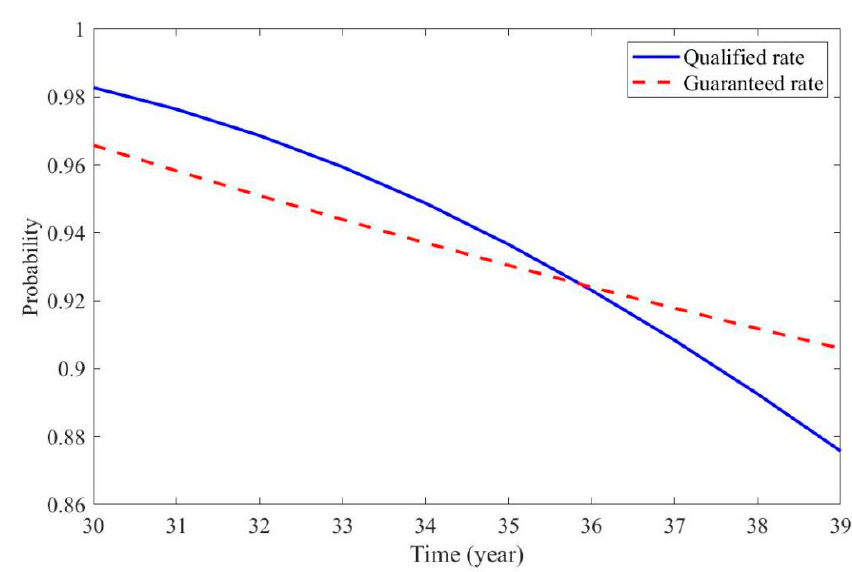
Appl. Sci. 2020 , 10 , 815 16 of 20 Figure 18. Time-varying qualified rate and guaranteed rate of f c = 18.0 N/mm 2 . Figure 18. Time-varying qualified rate and guaranteed rate of .